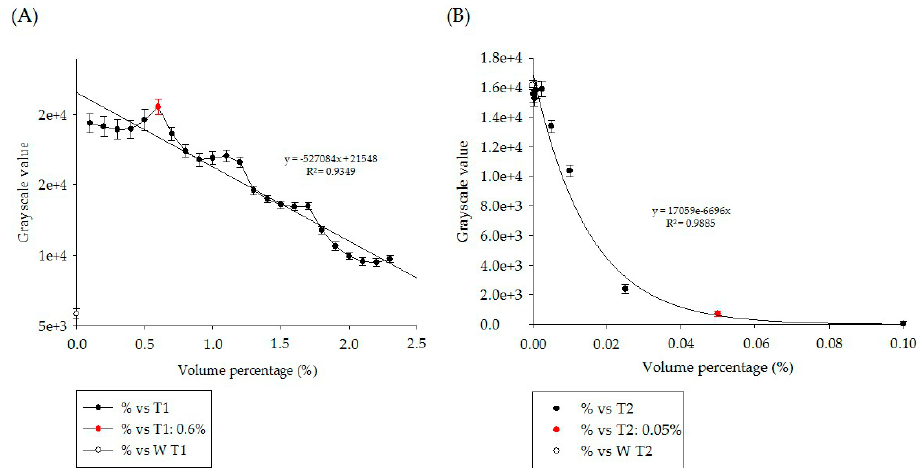
Figure 3. The curves of visualized grayscale numerical statistics of ( A ) paramagnetic contrast agent gadolinium-DTPA and ( B ) superparamagnetic contrast agent ferucarbotran samples diluted to different volume percentages under T1W and T2W pulse sequence imaging. Note that only nine points (from 0.1% to 0.00025%) in ( B ) were shown in order to clearly display the exponential distribution.